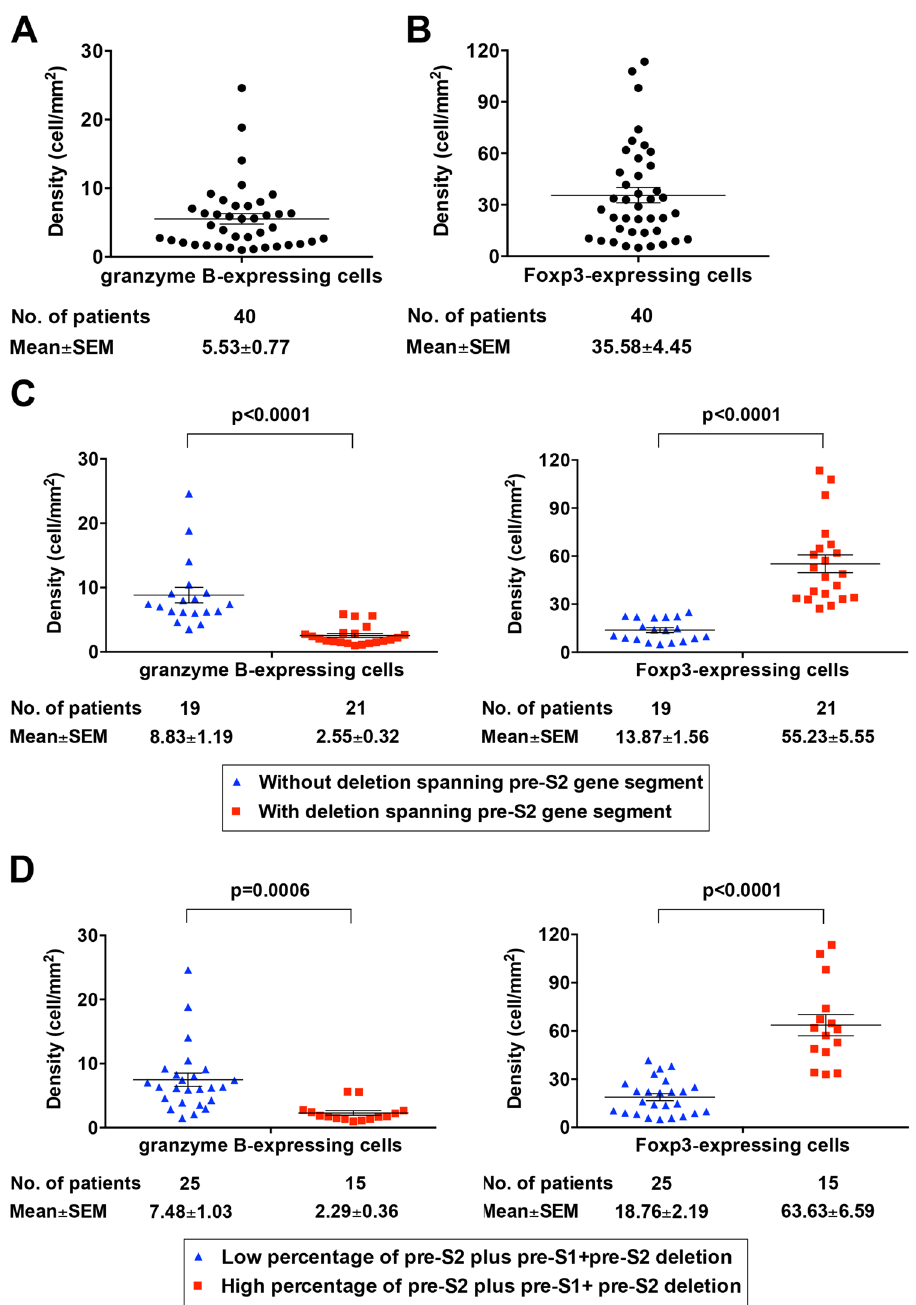
Figure 4. Pre-S2 mutant-positive patients displayed a significantly lower density of granzyme B- but higher density of Foxp3-expressing cells in HCC tissues. ( A ) Density of granzyme B-expressing cells in HCC tissues of total patients. ( B ) Density of Foxp3-expressing cells in HCC tissues of total patients. ( C ) Density of granzyme B-expressing cells (left graph) and Foxp3-expressing cells (right graph) in HCC tissues of patients with and without deletion spanning pre-S2 gene segment. ( D ) Density of granzyme B-expressing cells (left graph) and Foxp3-expressing cells (right graph) in HCC tissues of patients with high and low percentage of pre-S2 plus pre-S1 + pre-S2 deletion. Horizontal lines represented the mean values of the distribution. A P value < 0.05 was considered statistically